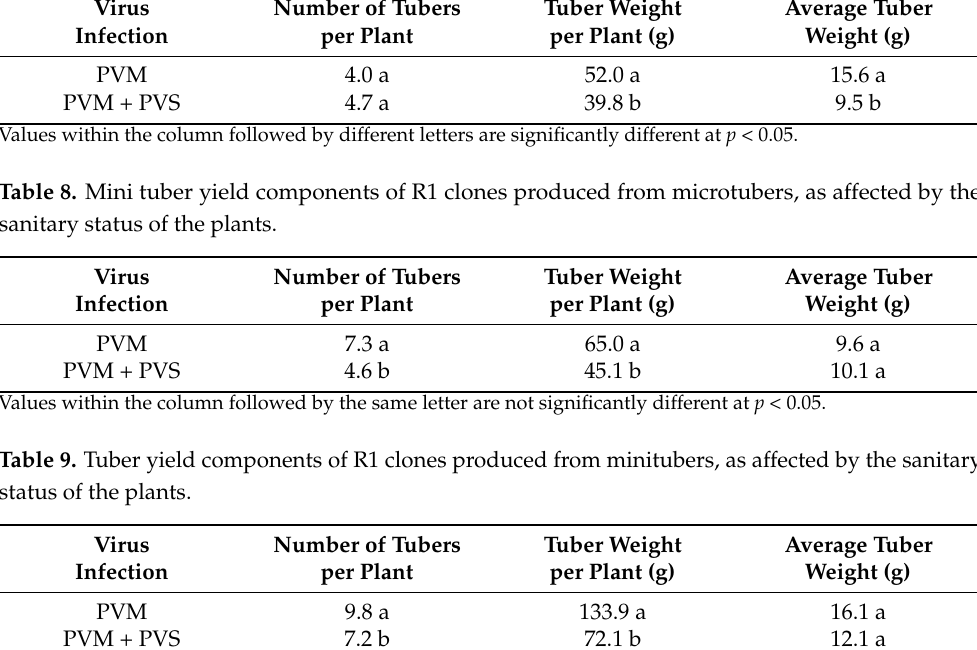
Table 7. Minituber yield components of R 0 clones produced from micropropagated plants, as affected by the sanitary status of the plants. Virus Number of Tubers Infection per Plant